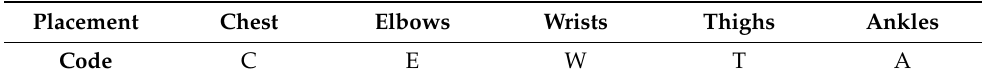
Figure 13. Training results of the LSTM model using different epochs. Table 3. Codes for the IMU